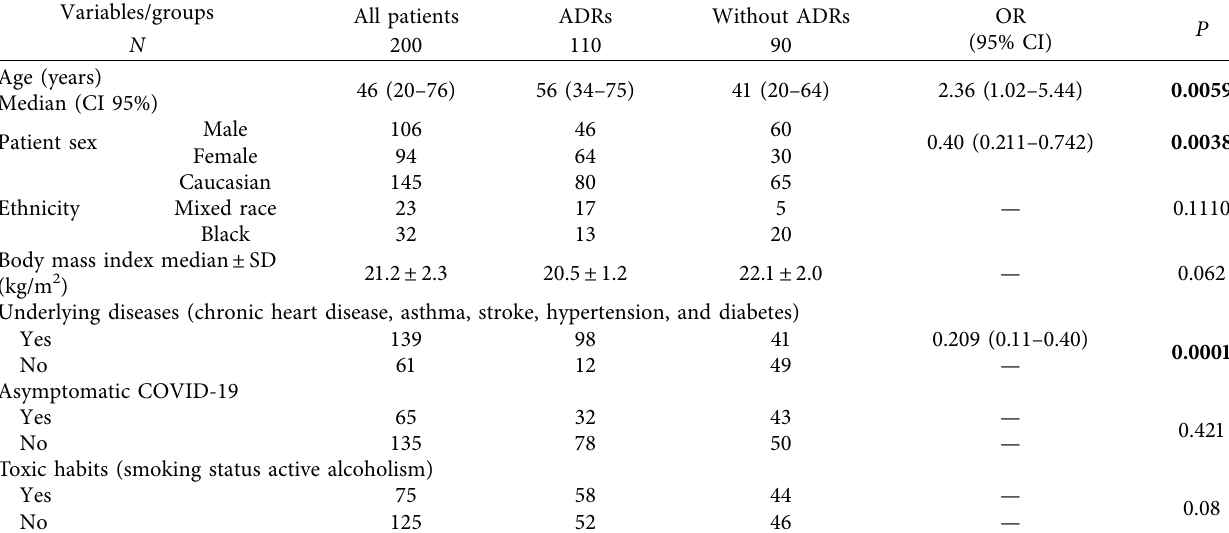
Table 1: Characteristics of patients with ADRs and without ADRs hospitalized at HEG-UCI, Pinar del Rio, and IPK, 2020. Variables/groups All